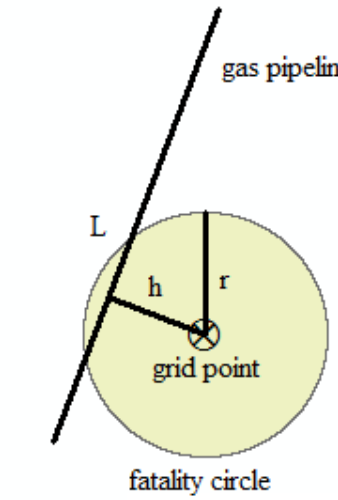
Figure 3. Relation Between Pipeline Parameters and Fatality